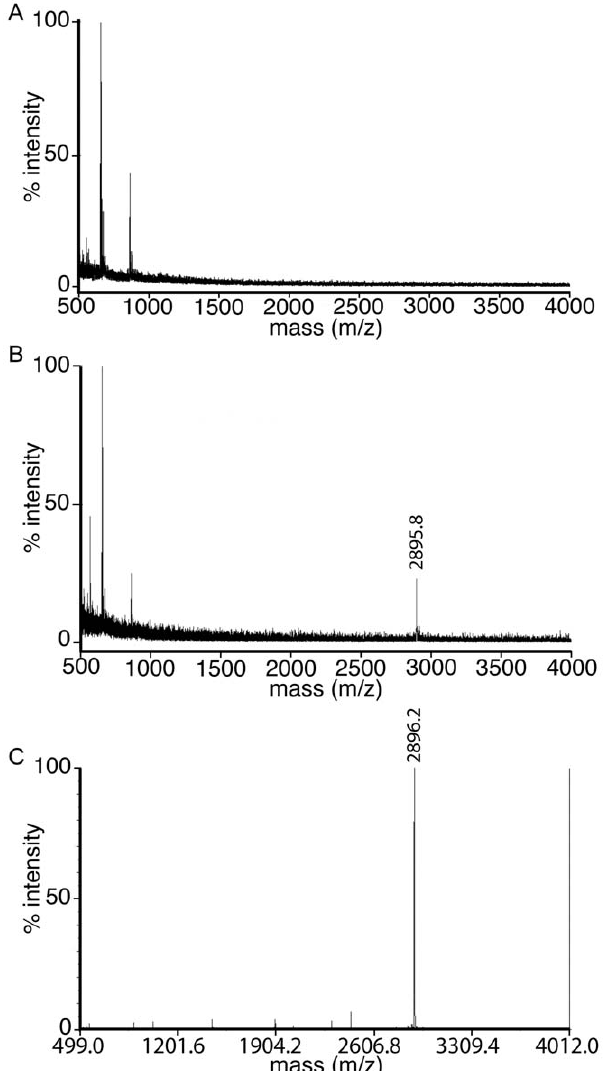
removal of the polyhistidine fusion sequence. Only matrix peaks are observed. (B) MALDI-TOF analysis of rIDE-E111F after cleavage of the polyhistidine fusion sequence. A peak representing bound ligand is evident. (C) MALDI-TOF analysis of the polyhistidine fusion tag eluted from Ni-NTA agarose resin after normal rIDE-E111F purification. This peak matches the peak representing ligand bound to purified rIDE- E111F in panel B and is consistent with the expected mass of the fusion